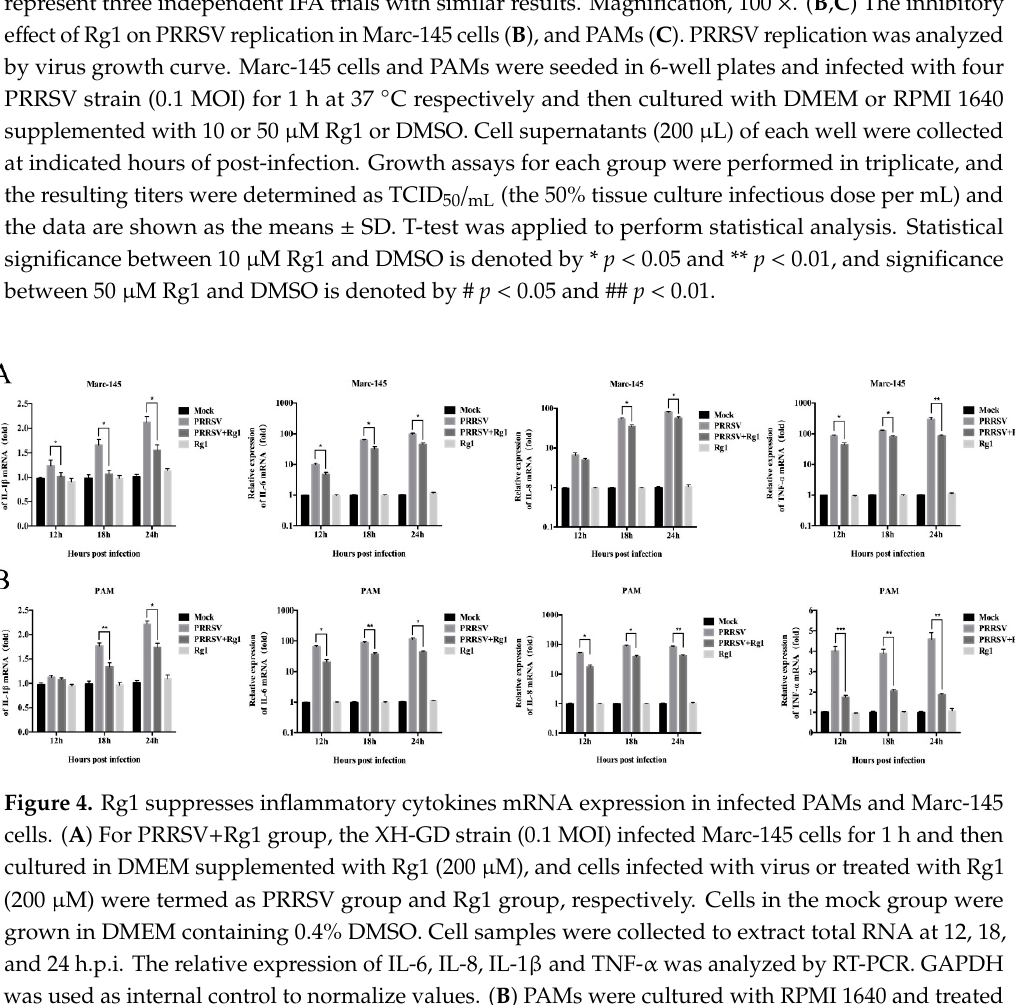
Figure 4. Rg1 suppresses inflammatory cytokines mRNA expression in infected PAMs and Marc-145 cells. ( A ) For PRRSV + Rg1 group, the XH-GD strain (0.1 MOI) infected Marc-145 cells for 1 h and then cultured in DMEM supplemented with Rg1 (200 µ M), and cells infected with virus or treated with Rg1 (200 µ M) were termed as PRRSV group and Rg1 group, respectively. Cells in the mock group were grown in DMEM containing 0.4% DMSO. Cell samples were collected to extract total RNA at 12, 18, and 24 h.p.i. The relative expression of IL-6, IL-8, IL-1 β and TNF- α was analyzed by RT-PCR. GAPDH was used as internal control to normalize values. ( B ) PAMs were cultured with RPMI 1640 and treated as described above. The data of each trial represents three independent experiments and the values are shown as the means ± SD. T-test was applied to perform statistical analysis and the significance was indicated by asterisk in the graphs. Statistical significance is denoted by * p < 0.05, ** p < 0.01, and *** p <